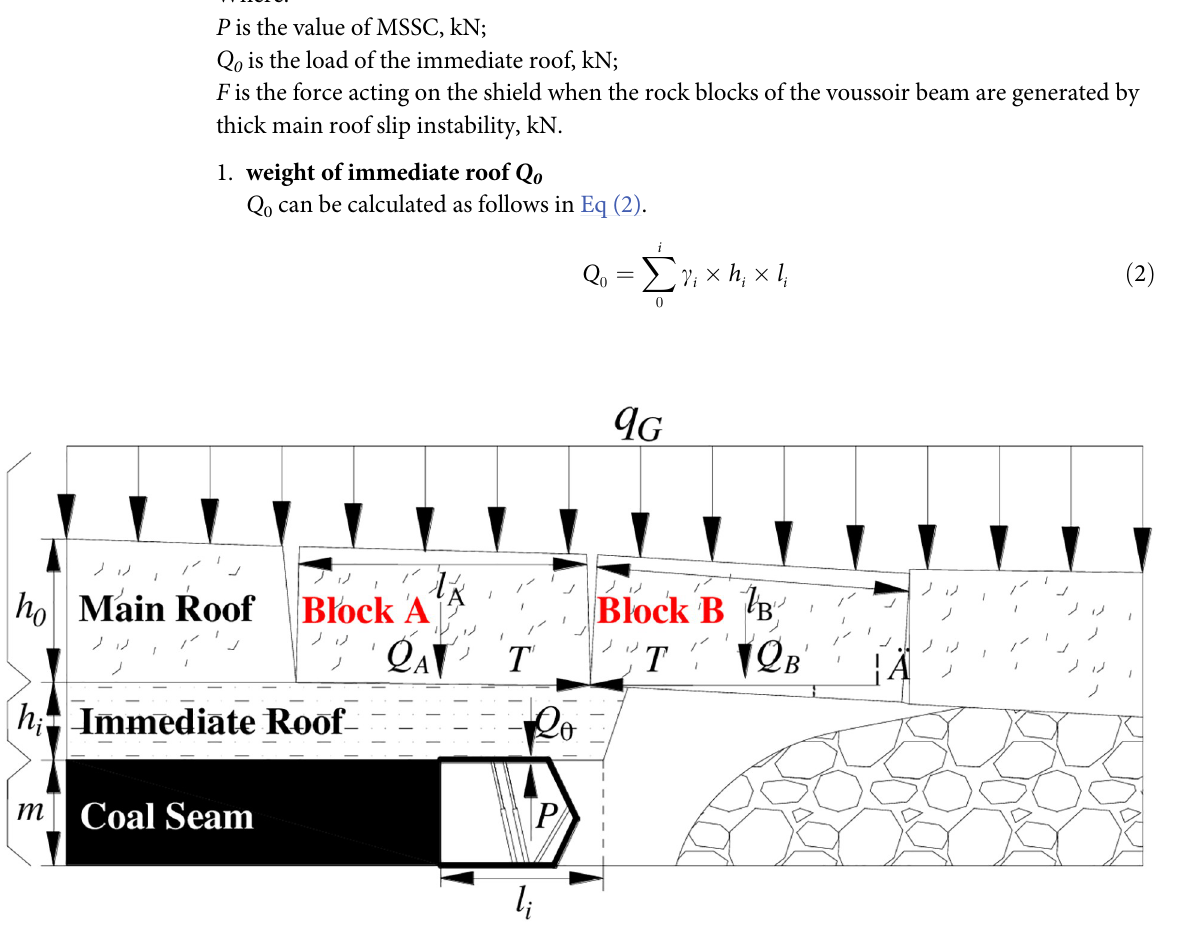
Fig 1. Articulated Structure of the Fractured Rock Blocks